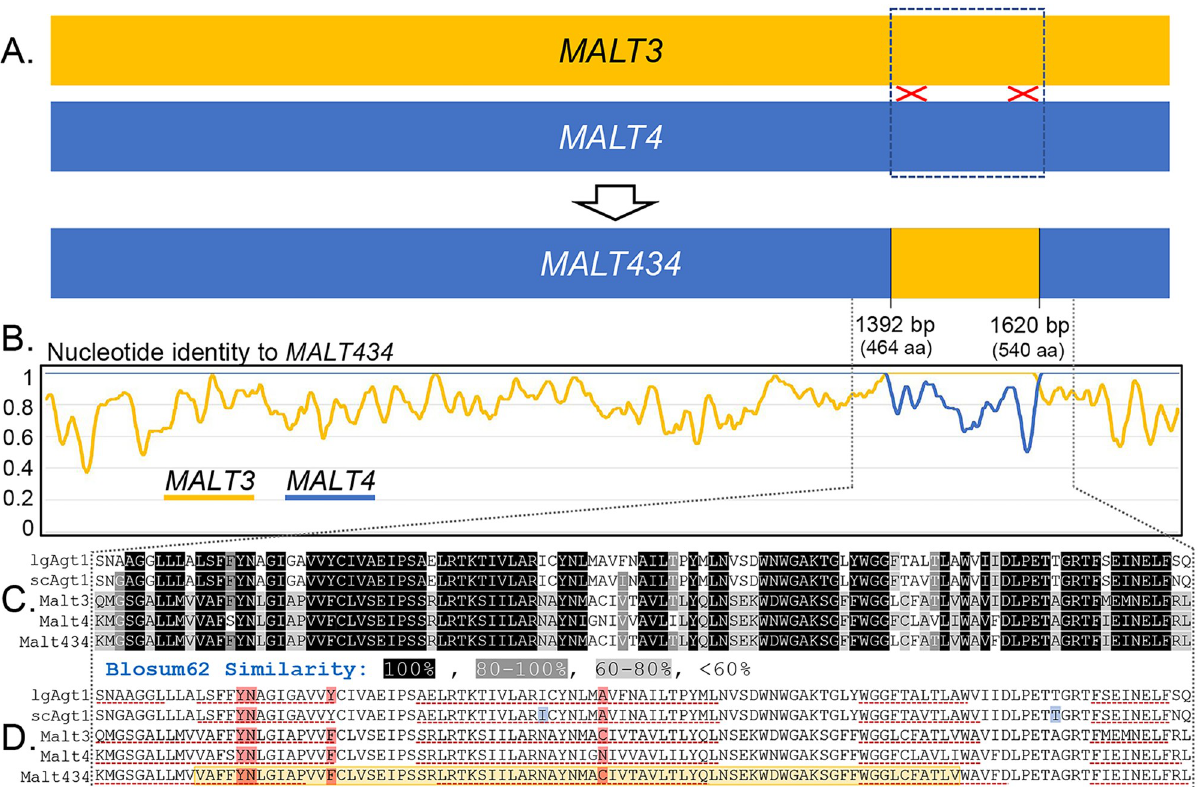
Fig 4. Sequence architecture of MALT434 . A) Schematic of the origin of MALT434 . B) Line graphs representing the identity between nucleotide sequences of MALT3 and MALT4 from WI- Seub (yHKS210) to MALT434 over 10-bp sliding windows. C-D) Segment of the alignment of the chimeric region between Malt3, Malt4, Malt434, scAgt1, and lgAgt1. The region highlighted in yellow in the Malt434 sequence indicates the chimeric region. The regions underlined with a red dashed line are predicted transmembrane domains. The amino acids highlighted in red are predicted maltose-binding residues. The residues highlighted in blue were experimentally found to be important for maltotriose transport by Smit et al . 2008.